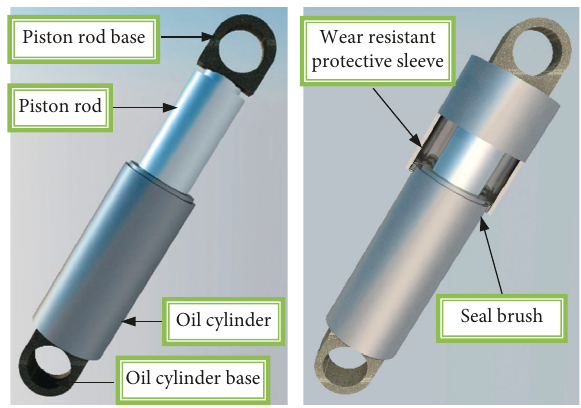
Figure 11: Schematic diagram of piston rod protection device.